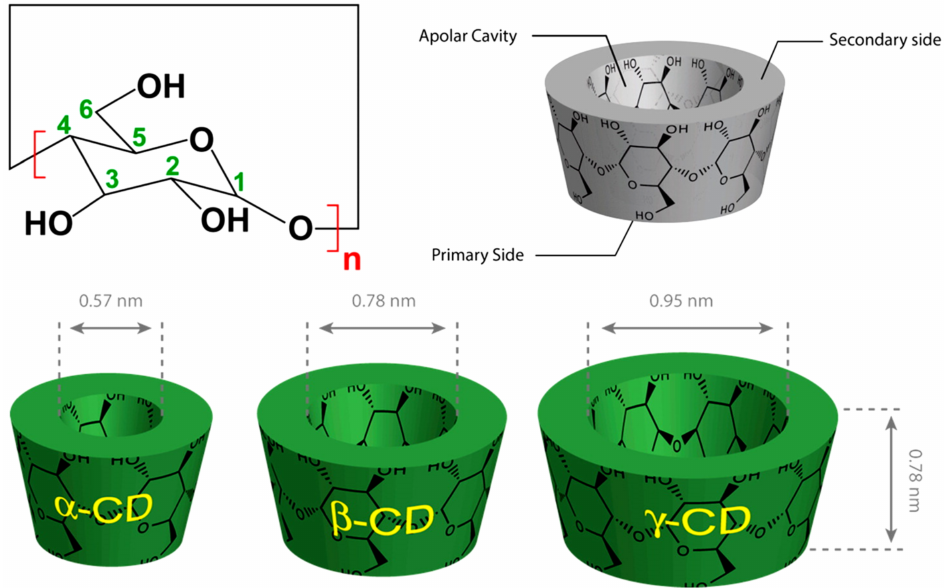
Figure 5. Types of cyclodextrins; α -CD (n = 6), β -CD (n = 7), and γ -CD (n = 8) with their geometric dimensions (bottom) [57].